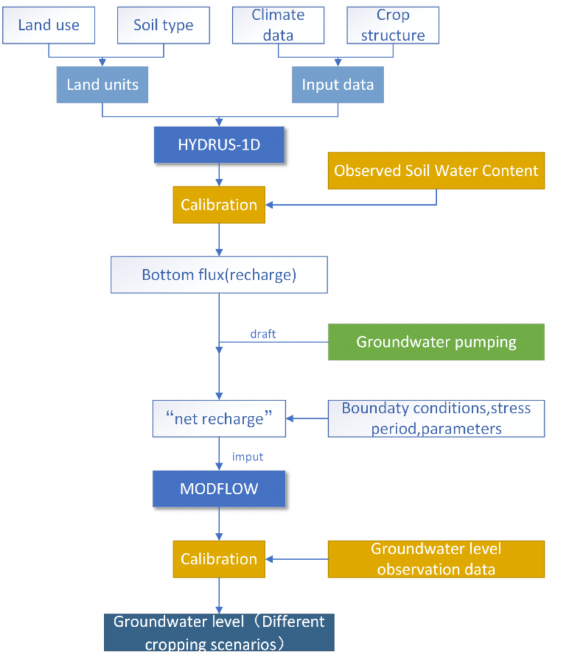
Figure 3. Flow chart of the aquifer simulation using HYDRUS-1D and